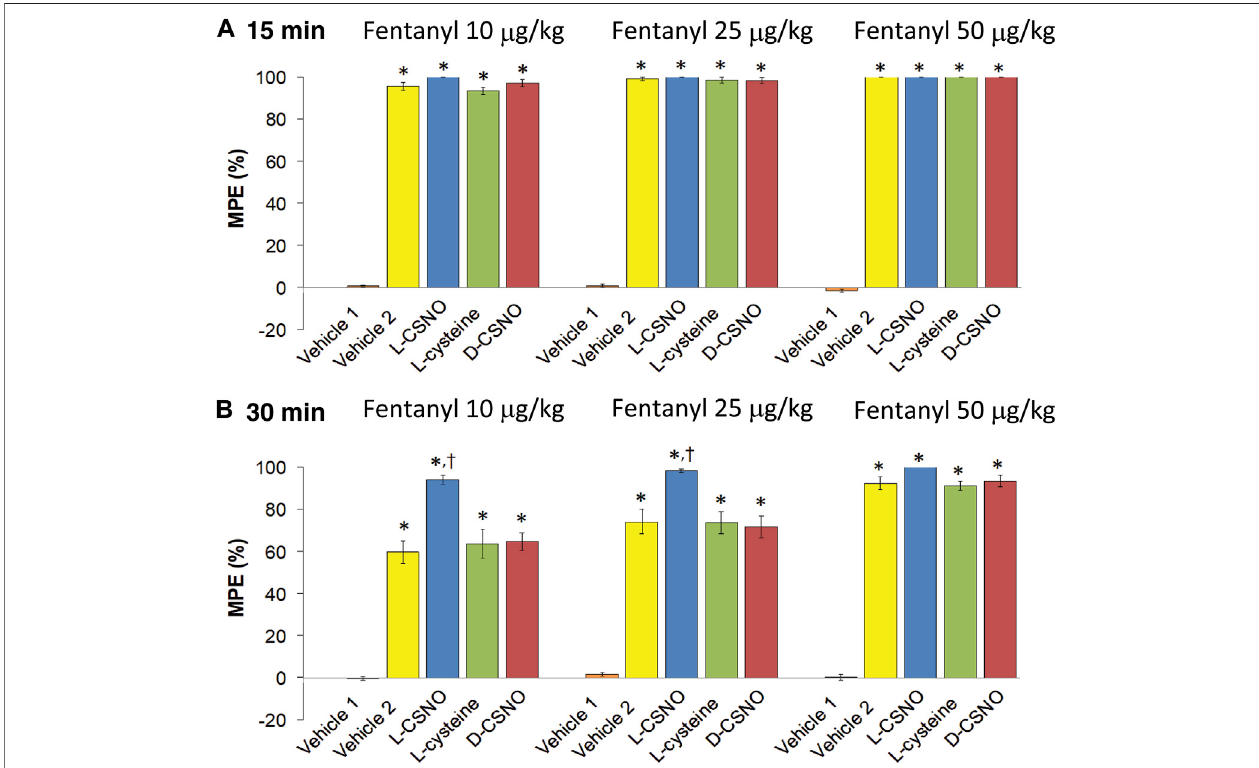
FIGURE11| Changesintail- fl icklatencies15 min (A) and30 min (B) followinginjectionoffentanyl(10,25,and50 μ g/kg,IV)expressedasmaximalpossibleeffect (MPE, %). Vehicle 1 rats received an infusion of vehicle, three injections of vehicle and then an injection ofNLXmi(2.5 mg/kg, IV) 30 min after the third injection of vehicle. Vehicle2ratsreceivedaninfusionofvehiclefor60 minbeforereceivinginjectionsof10,25,or50 μ g/kgdosesoffentanylgiven30 minapartandtheninjectionofvehicle, 30 min after injection of 50 μ g/kg dose of fentanyl. The groups denoted as L-CSNO, L-cysteine or D-CSNO received infusions at 200 nmol/kg/min for 60 min beforereceivinginjectionsof10,25,or50 μ g/kgdosesoffentanylgiven30 minapartandaninjectionofNLXmi(2.5 mg/kg, IV)30 minafterinjection of50 μ g/kgdoseof fentanyl. The data are presented as mean ± SEM. There were 6 rats in each group. * p < 0.05, signi fi cant change from Pre values. † p < 0.05, L-CSNO versus Vehicle 2, L-cysteine and